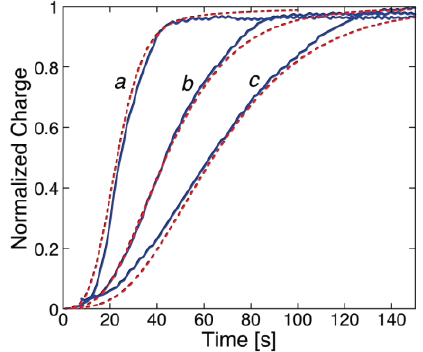
Figure 7. The solid blue curves are three successive charge vs. time curves at a DPTL/DPhPC tBLM following potential steps from the same initial value −0.20 V to the final values −1.05 V (a), −1.00 V (b) and −0.95 V (c) in aqueous 0.1 M KCl containing 0.14 μM melittin. The height of the plateau of the curves is normalized to unity. The corresponding dashed red curves were calculated using the parameters θ 0 = 0.2, n = 2, and k N k R 2 = 0.05 s −3 for all three curves; p was given the value 1 for curve (a), 0.8 for curve (b) and 0.6 for curve (c). (Reprinted with permission from [30] . Copyright 2007, American Chemical Society).